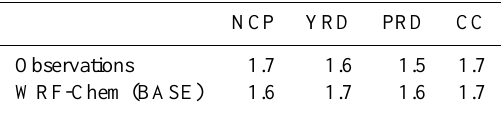
Table 3. Observed and simulated enhancement ratios of PM 2 . 5 . The enhancement ratio is defined as the average of daily PM 2 . 5 larger than the median value divided by that of hourly PM 2 . 5 less than the median value during the month. NCP, YRD, PRD, and CC as defined in the